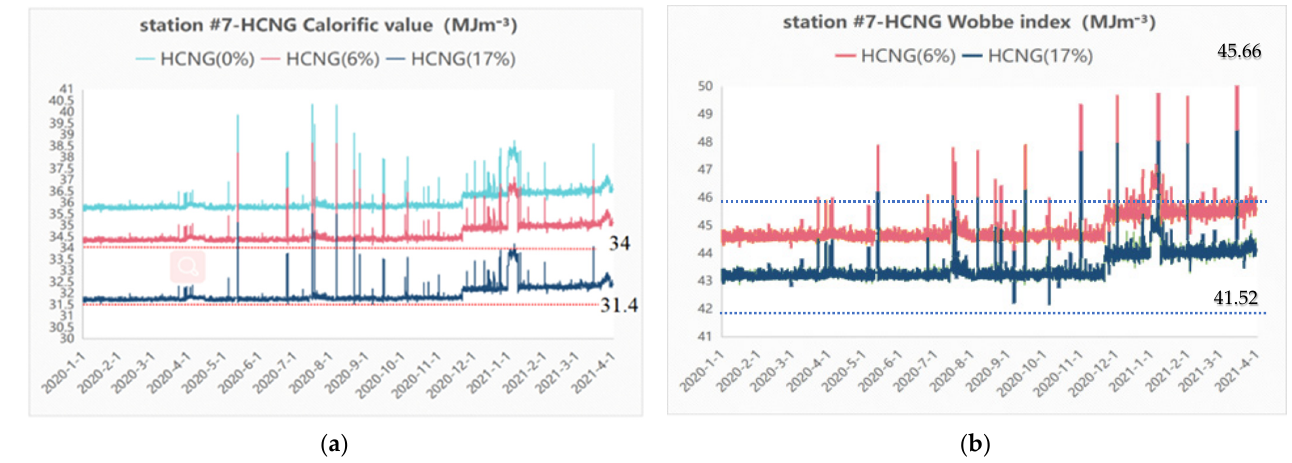
Figure 9. ( a ) Calorific value of natural gas source station #7 measured between January 2020 and March 2021. ( b ) Wobbe Index of natural gas source station #7 measured between January 2020 and March 2021.